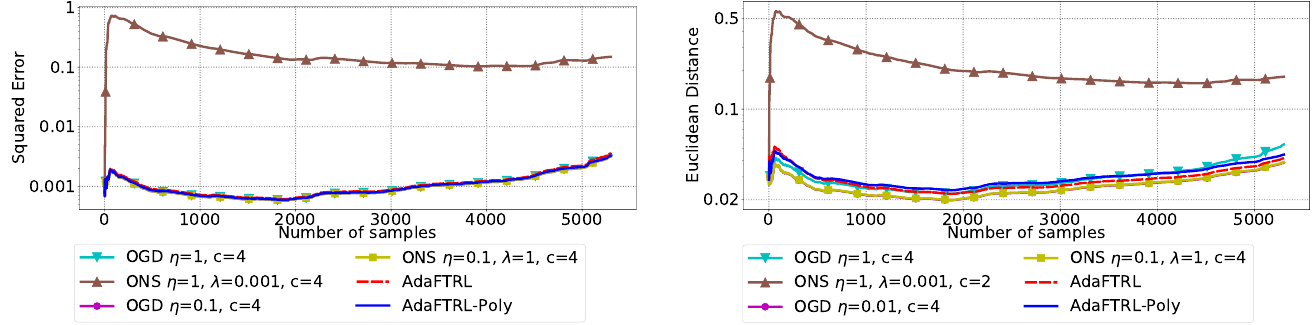
Figure 4. Results for stock data.